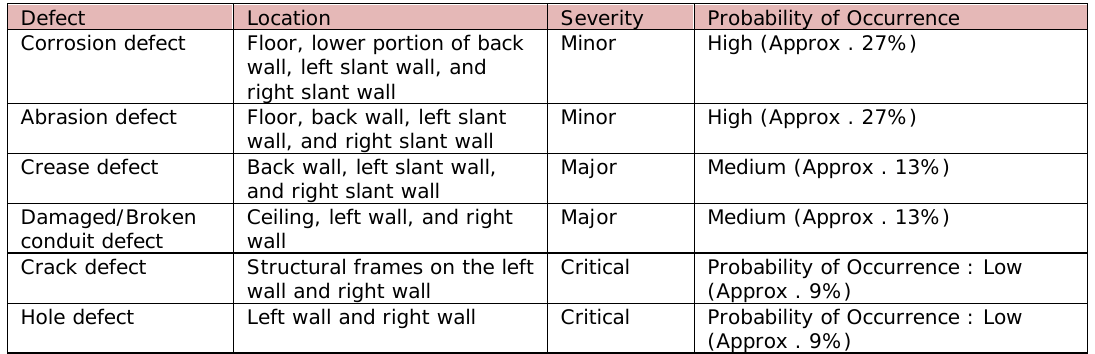
Table 1. “Defects chosen for VR Simulator”. Source: Own